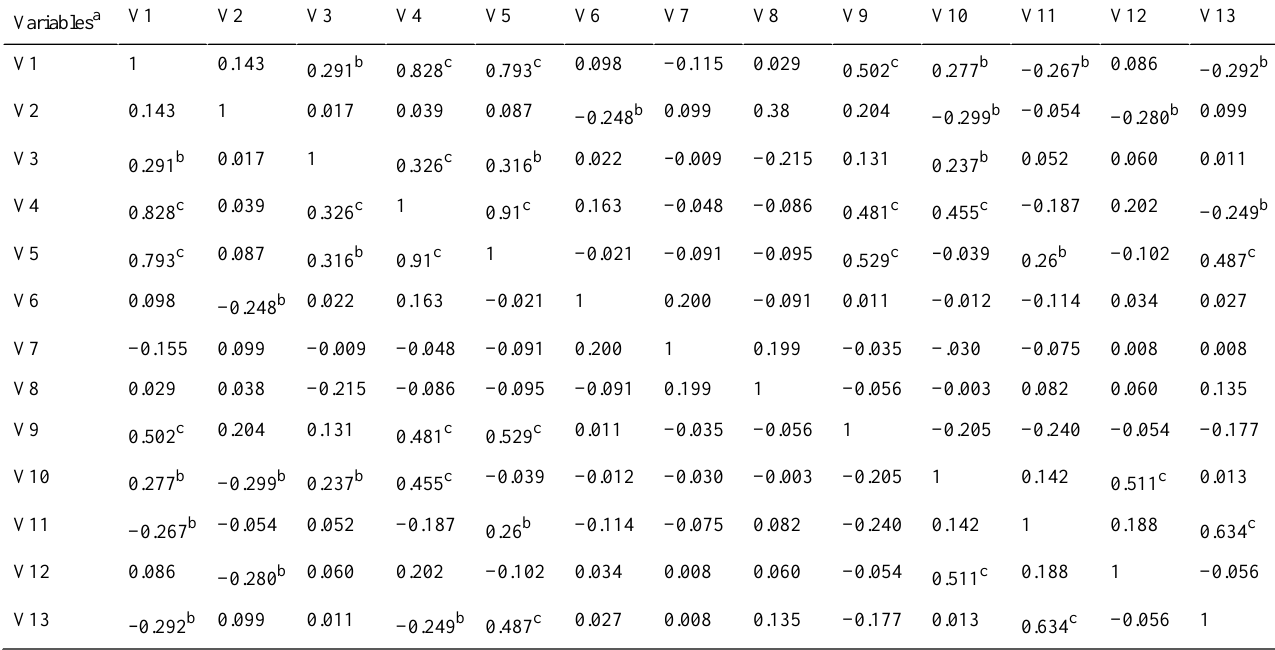
Table 12. Correlations between